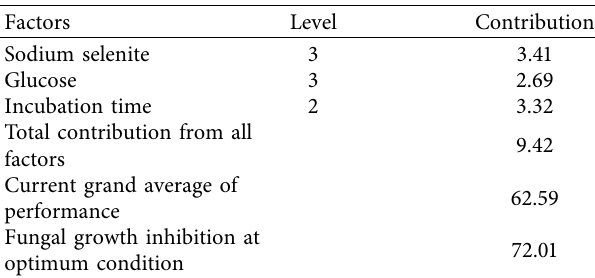
Table 5: The optimum conditions for the synthesis of selenium nanoparticles with the highest antifungal